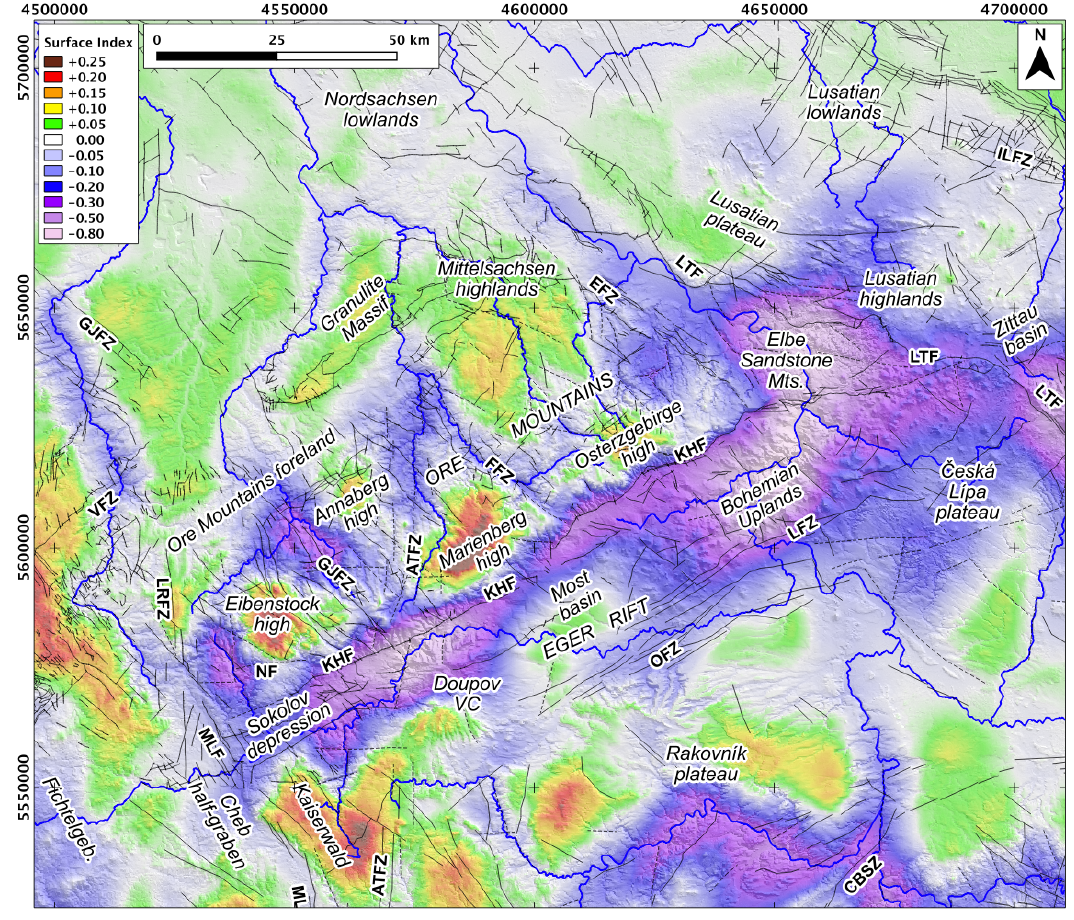
surfaces. Negative values reveal incised regions. See Figure 2 for